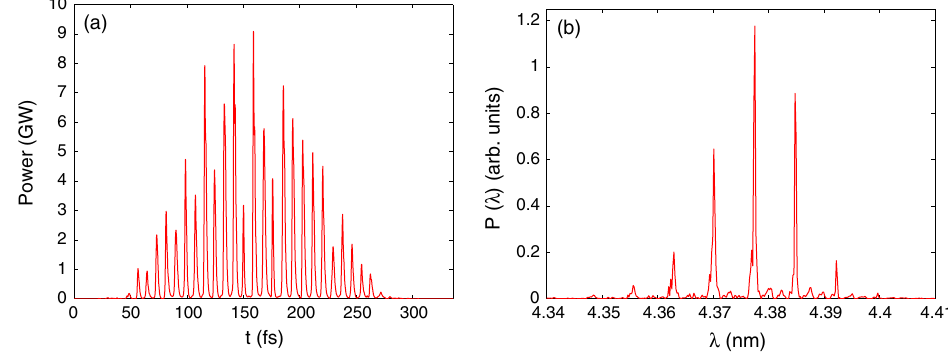
FIG. 8. FEL power and spectrum after the coherent seed is amplified by the density-modulated beam in 7 undulator